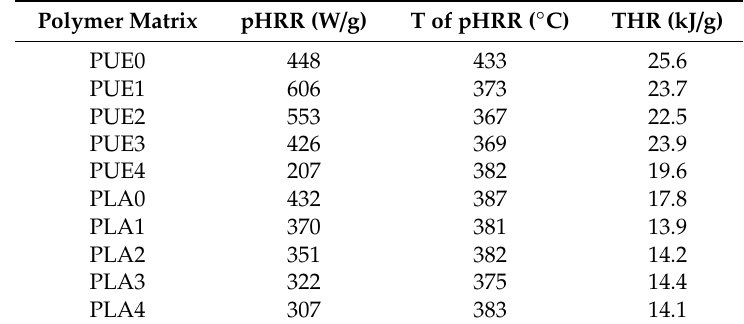
Figure 11. Heat release rate and mass for PLA/APP/S9 composites from cone calorimeter. Table 5. Cone calorimeter results for PUE/APP/S9 and PLA/APP/S9 composites. Polymer Matrix